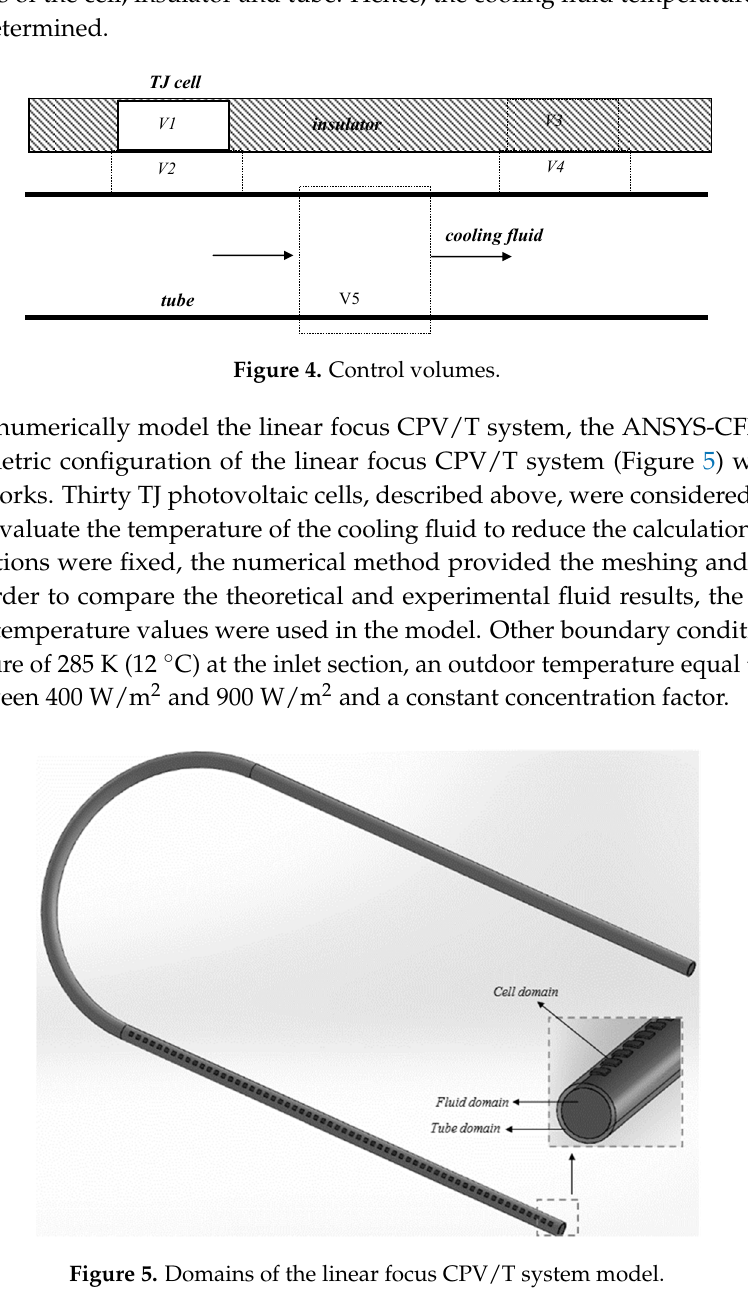
Figure 5. Domains of the linear focus CPV/T system model.